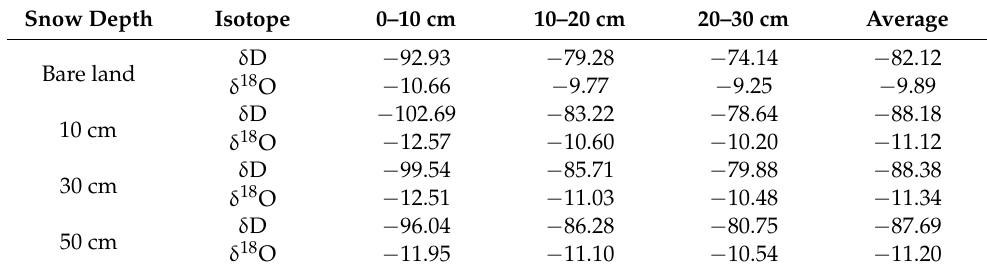
Table 3. Distribution of the isotope values of the soil for different snow depths (‰). Snow